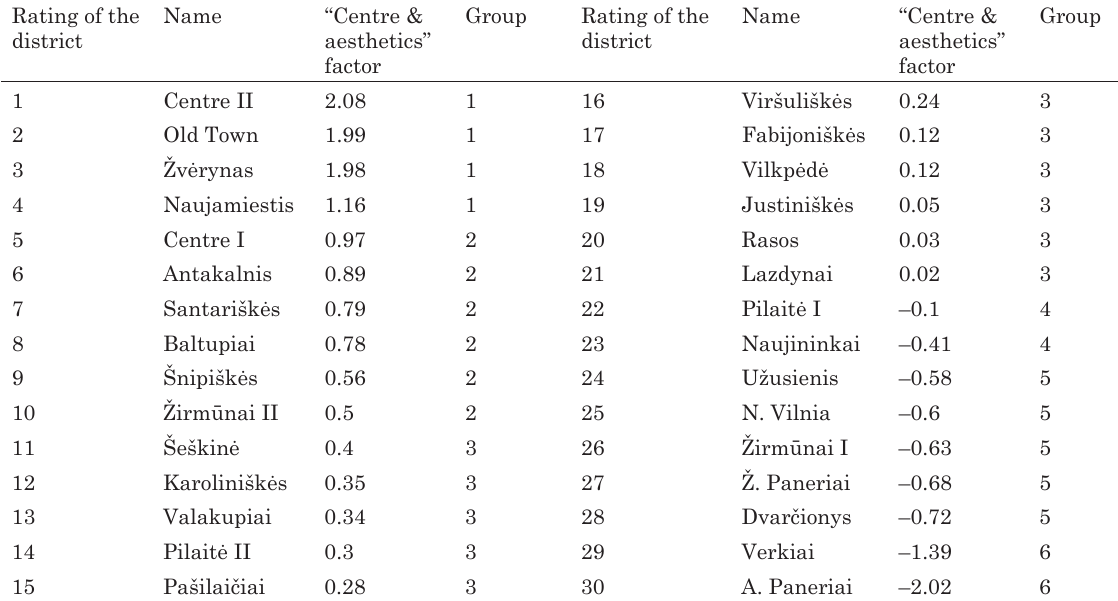
table 2. Values of the “centre & aesthetics” factor in Vilnius districts rating of the